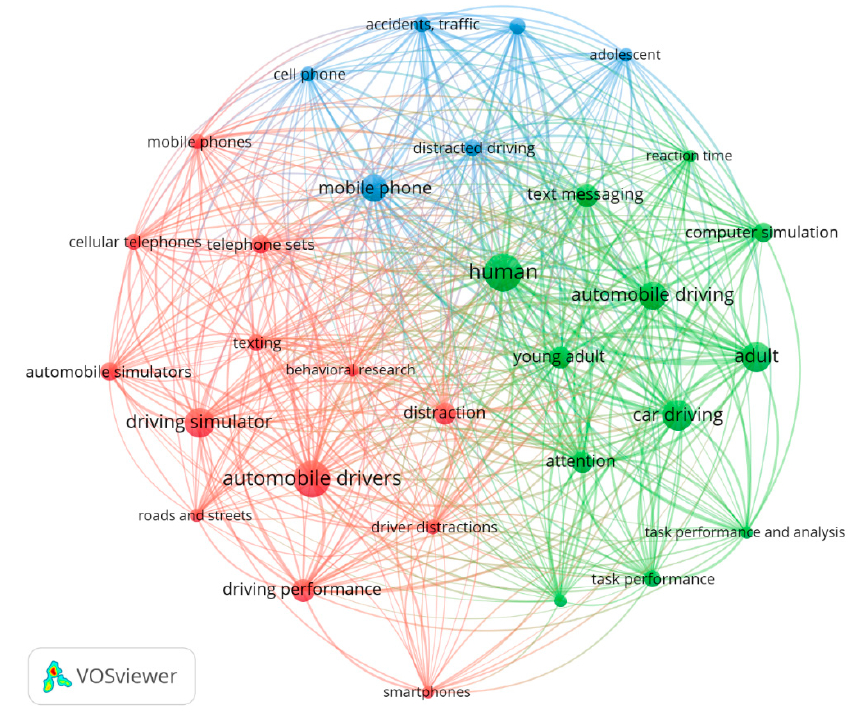
Figure 4. Network diagram of the most frequently used terms.